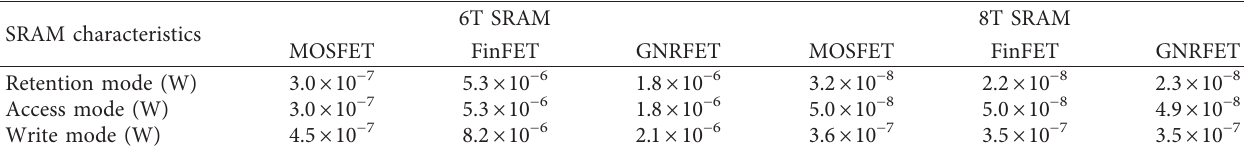
Table 5: Analysis of average power consumption of MOSFET-, FinFET-, and GNRFET-based